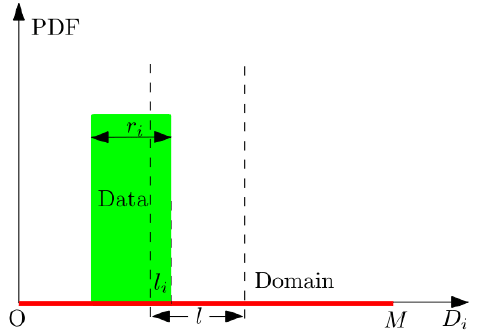
Figure 4. PDF of a non-uniform dimension illustrated by the